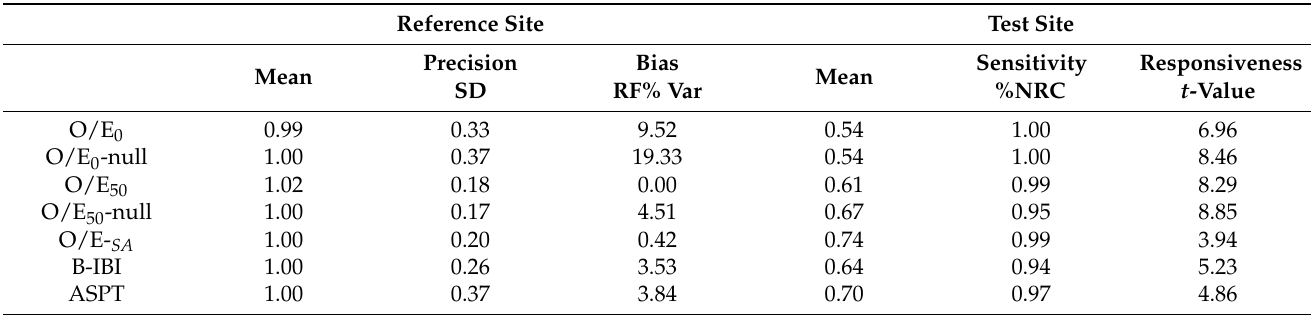
Table 1. Index performance based on precision, bias, sensitivity, and